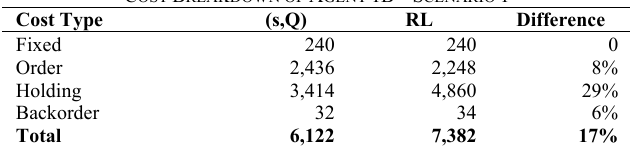
TABLE 6 C OST B REAKDOWN OF A GENT 1B – S CENARIO